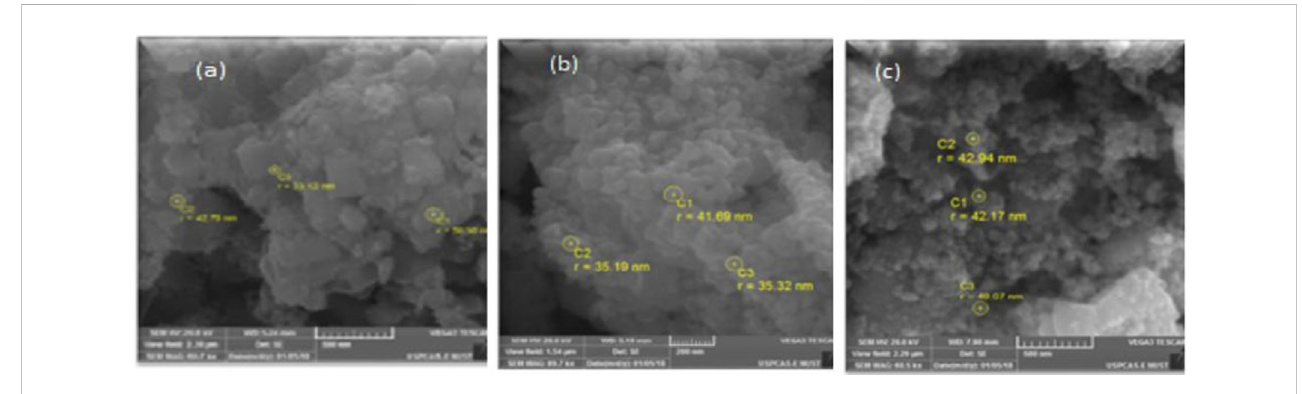
FIGURE 2 (A – C) SEM micrographs of La 1-x Ca x MnO 3 (x = 0.1, 0.2, or 0.3).